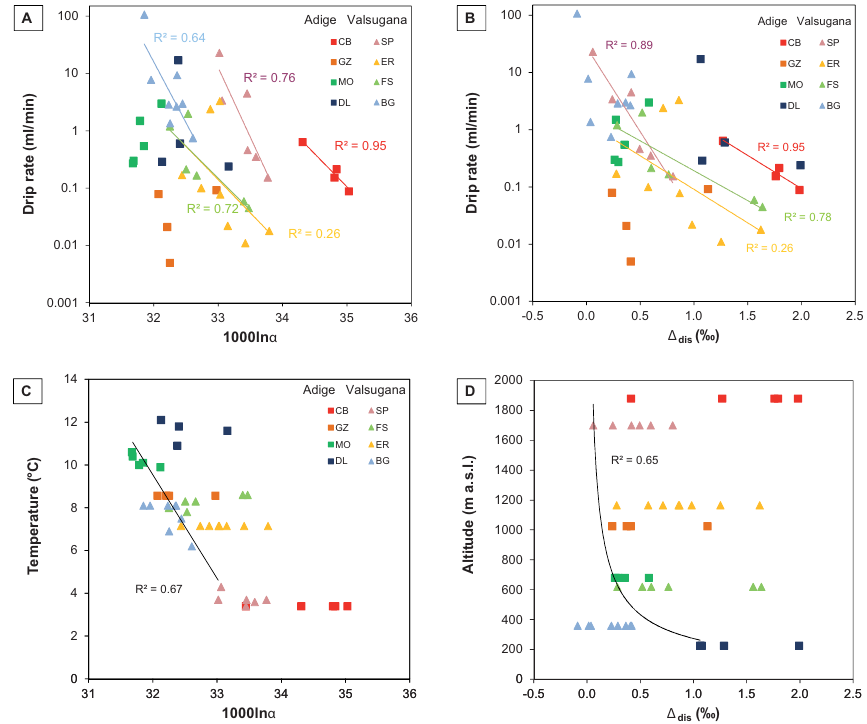
Fig. 7. Calcite-water fractionation factors and 1 dis as a function of drip rate, temperature and altitude for the caves of Trentino. (A) Frac- tionation factor and (B) 1 dis as a function of drip rate. Caves with drip rates extending several orders of magnitude exhibit exponential relationships (note log scale), indicating faster drip rates reduce the fractionation factor and the magnitude of possible isotope disequilibrium effects ( 1 dis ). However, there is no trend in the dataset as a whole and a few of the caves exhibit no significant trend, but this may be due to the limited dataset or to site specific factors. (C) Fractionation factors plotted against the cave temperature. A linear relationship ( R 2 =0.67) is exhibited for the least modified samples from each cave, excluding the CB cave, where the least modified calcite has no counterpart drip- water. (D) 1 dis is plotted as a function of altitude as a more independent assessment than temperature, since the calculation of 1 dis contains δ 18 O e that accounts for temperature within the equation of Kim and O’Neil (1997).